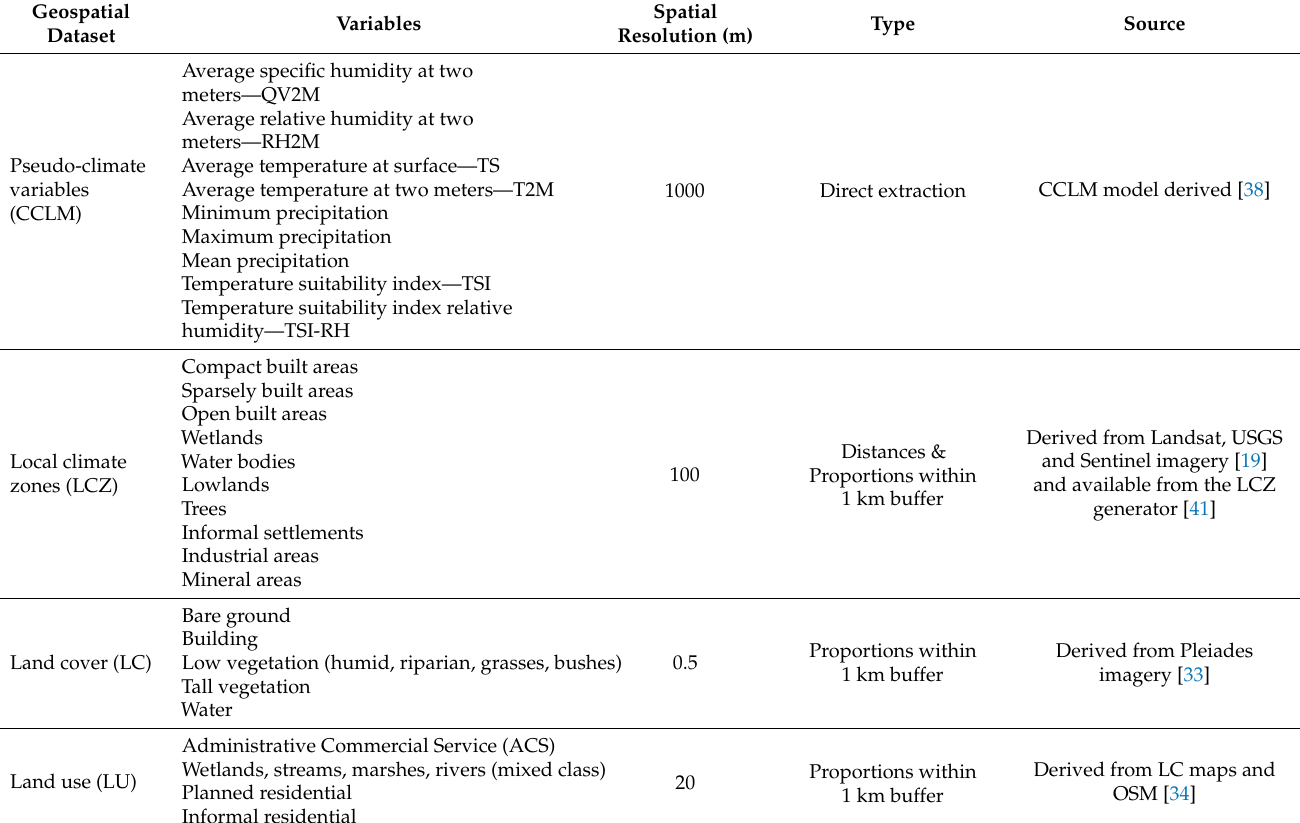
Table 1. Geospatial datasets used as